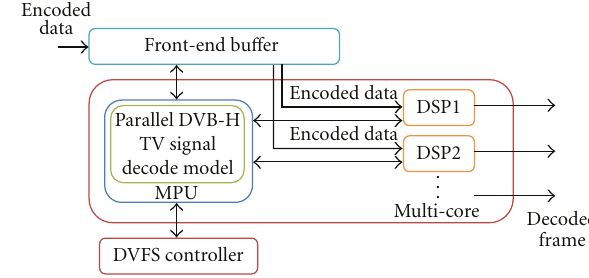
Figure 6: Macroblock Decoding References.